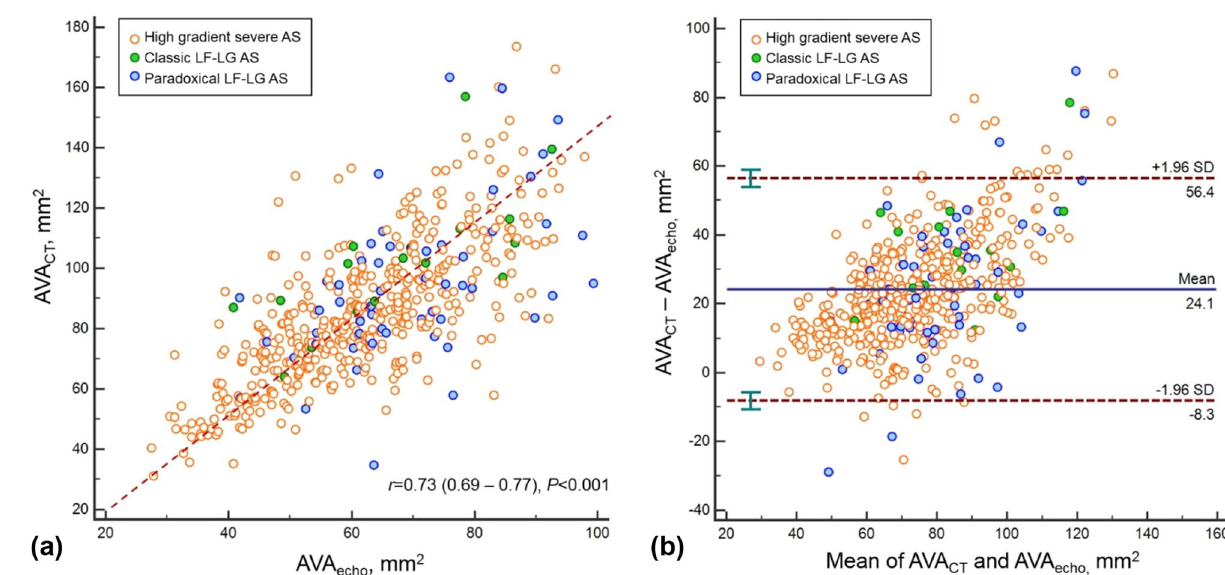
Figure 2. ( a ) Pearson correlation analysis result and ( b ) Bland–Altman plot to comparison of AVA CT and AVA echo . AS aortic stenosis, AVA aortic valve area, LF-LG low-flow and